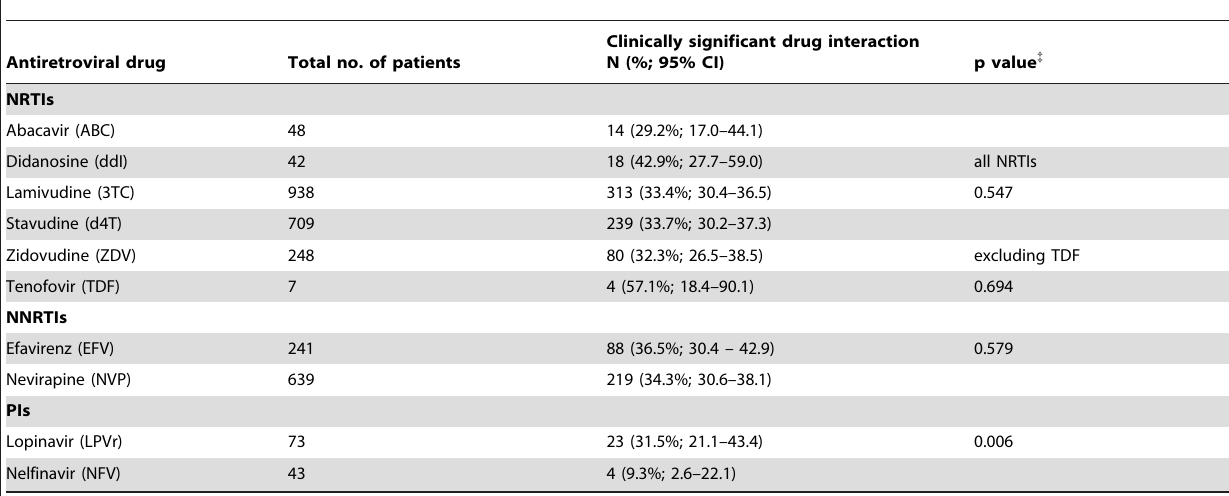
Table 3. Risk of Clinically Significant Drug Interaction by Individual